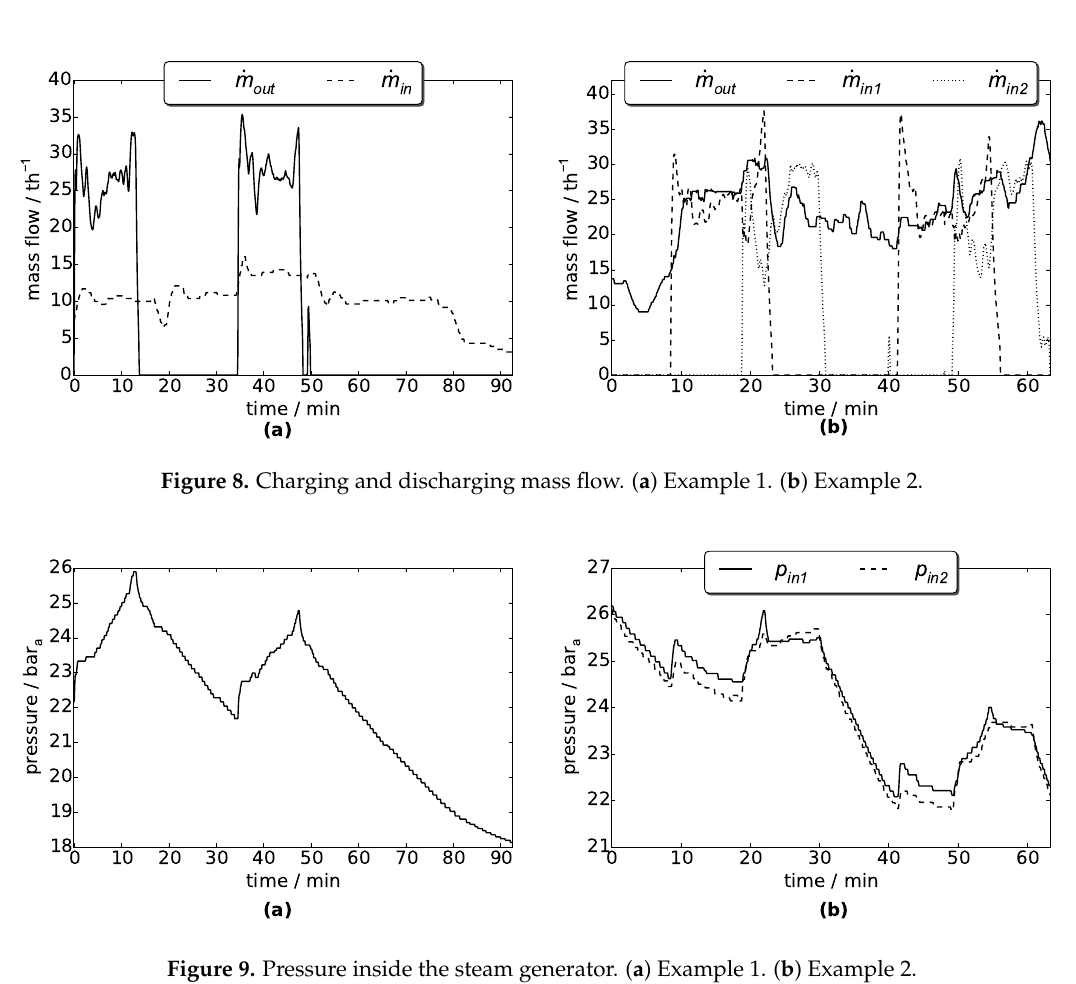
Figure 9. Pressure inside the steam generator. ( a ) Example 1. ( b ) Example